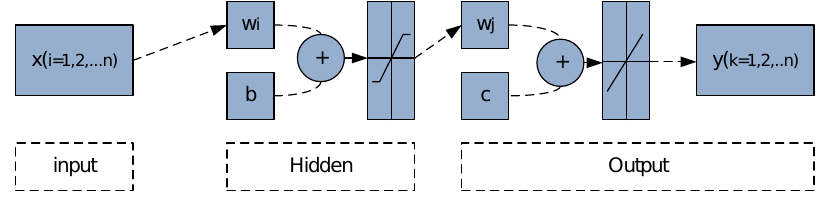
Figure 2. Back-propagation neural networks